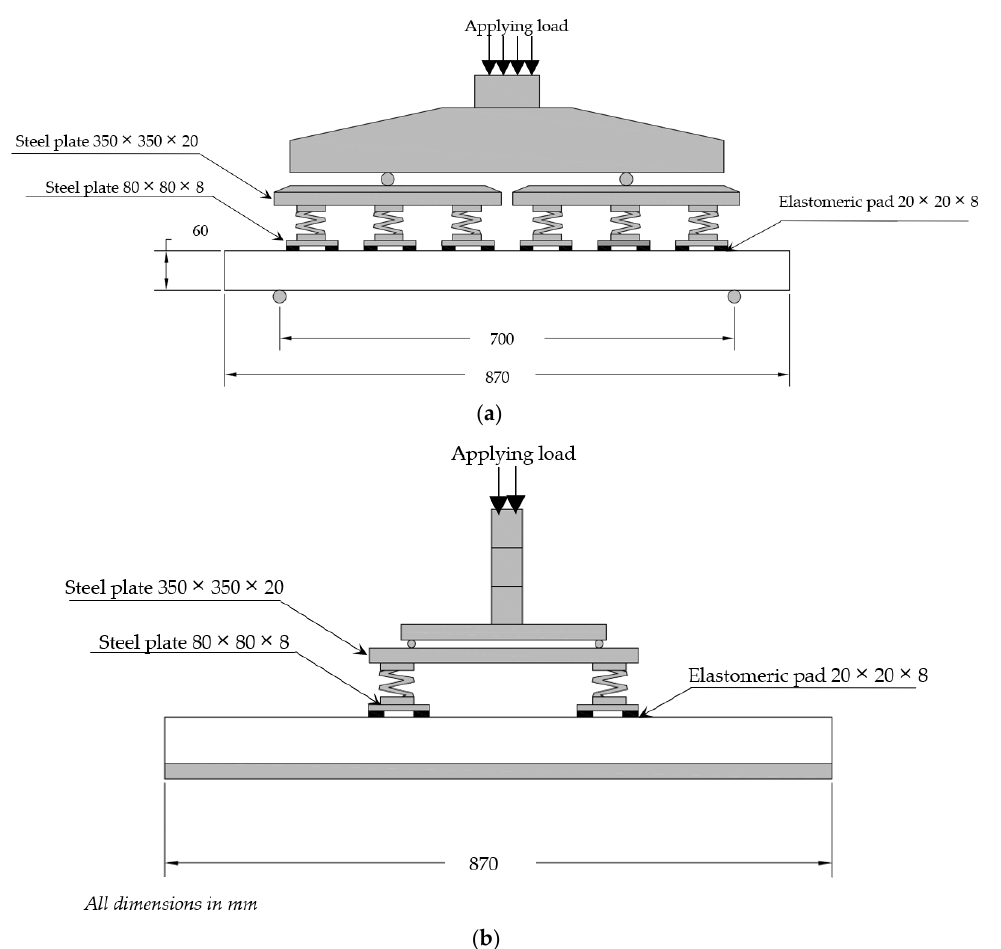
Figure 3. Details of slab ( a ) front view, ( b ) side view.